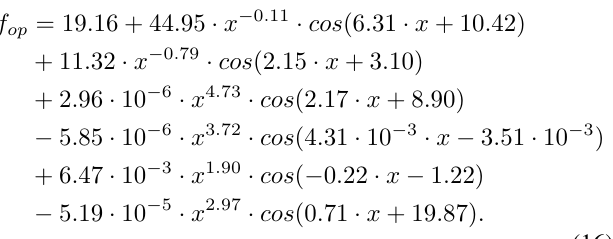
Fig. 4 illustrates the experimental and optimized curves obtained with F aval = 1 . 97 · 10 − 1 . Within the same figure, there is a cut at the point x = 3 , which illustrates the difference between both curves, with the order of the distance between them of approximately 10 − 2 .